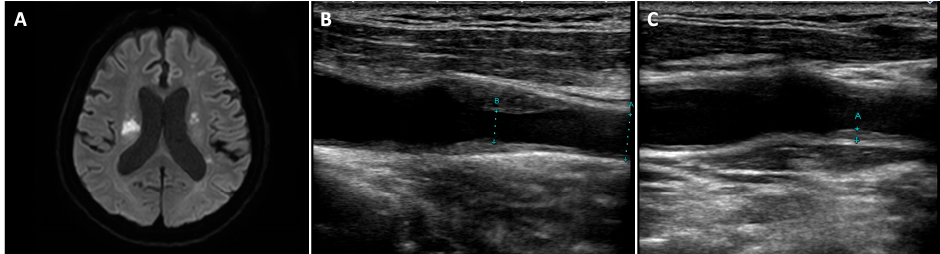
Figure 1. Diffusion-Weighted Magnetic Resonance Imaging (DW-MRI) of the brain and echocardiogram of the left and right carotid arteries. ( A ) Multiple infarcts in the left middle cerebral artery territory, right corona radiata, and right internal capsule shown in DW-MRI; ( B , C ) stenosis and plaque showed in the right ( B ) and left ( C ) carotid arteries.